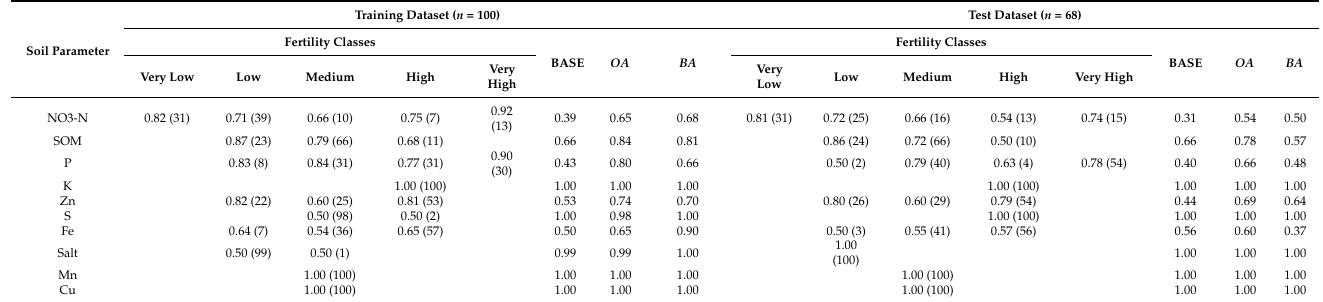
Table 8. Area under the curve ( AUC ) values for each class of each soil property that can be separated into fertility classes (see Table 4). The percentage of N (number of observation) in each class within each dataset is indicated within parenthesis. The baseline (BASE), overall accuracy ( OA ), and balanced accuracy ( BA ) calculated with the confusion matrix of each soil property are